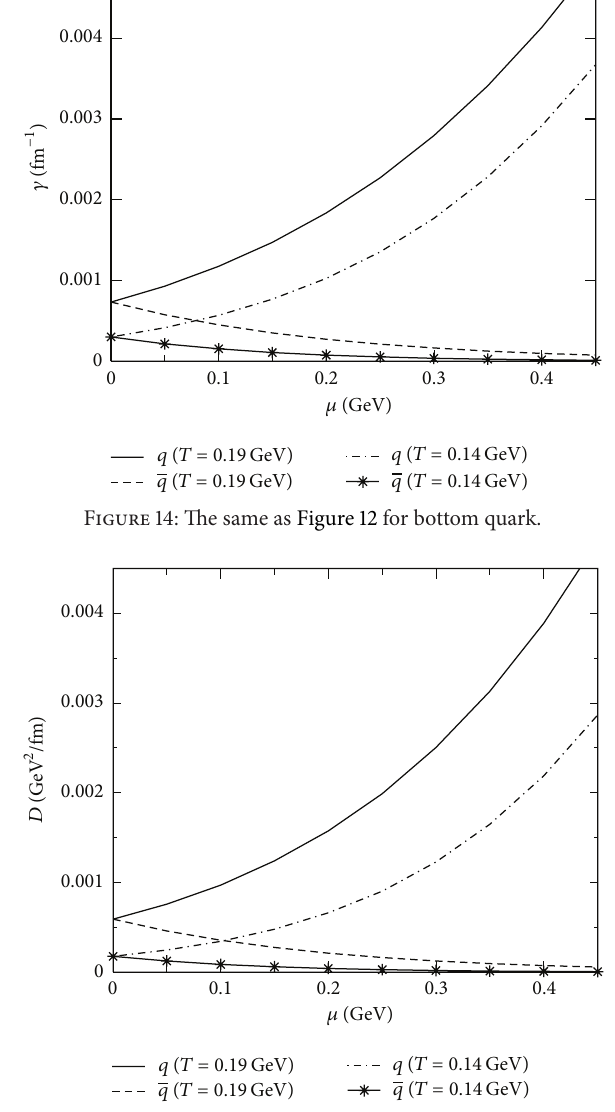
Figure 15: The same as Figure 13 for bottom